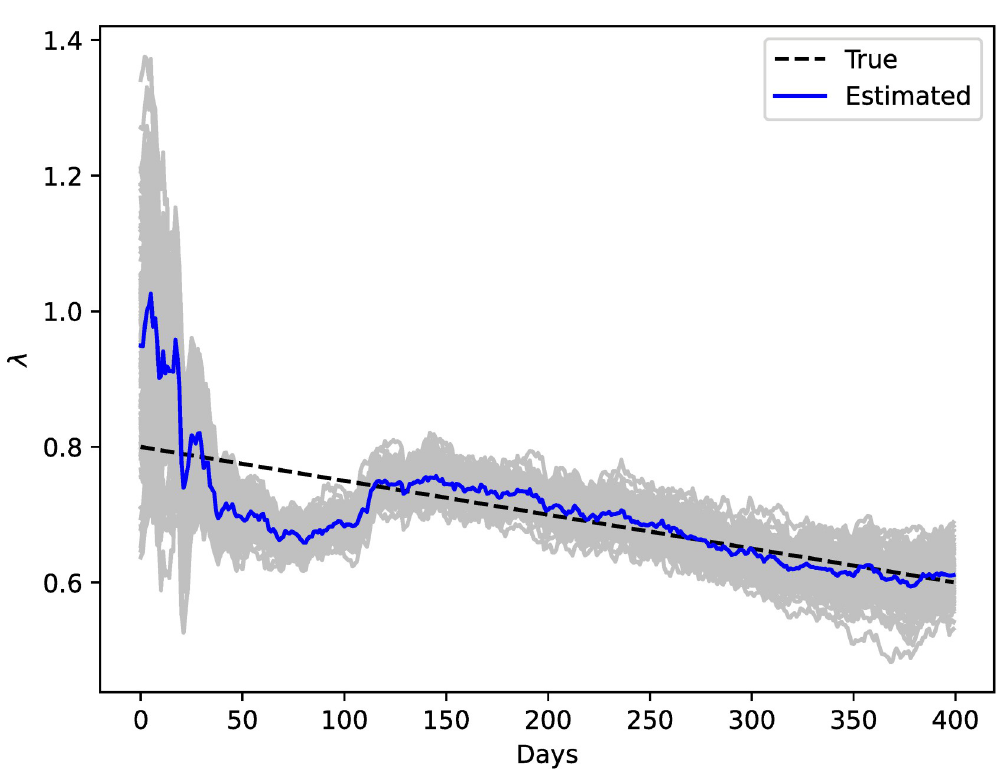
Fig 4. Estimations of λ . The estimated values as a function of time are shown in solid blue line. Grey lines indicate ensemble members. The true evolution is drawn with a dashed line.